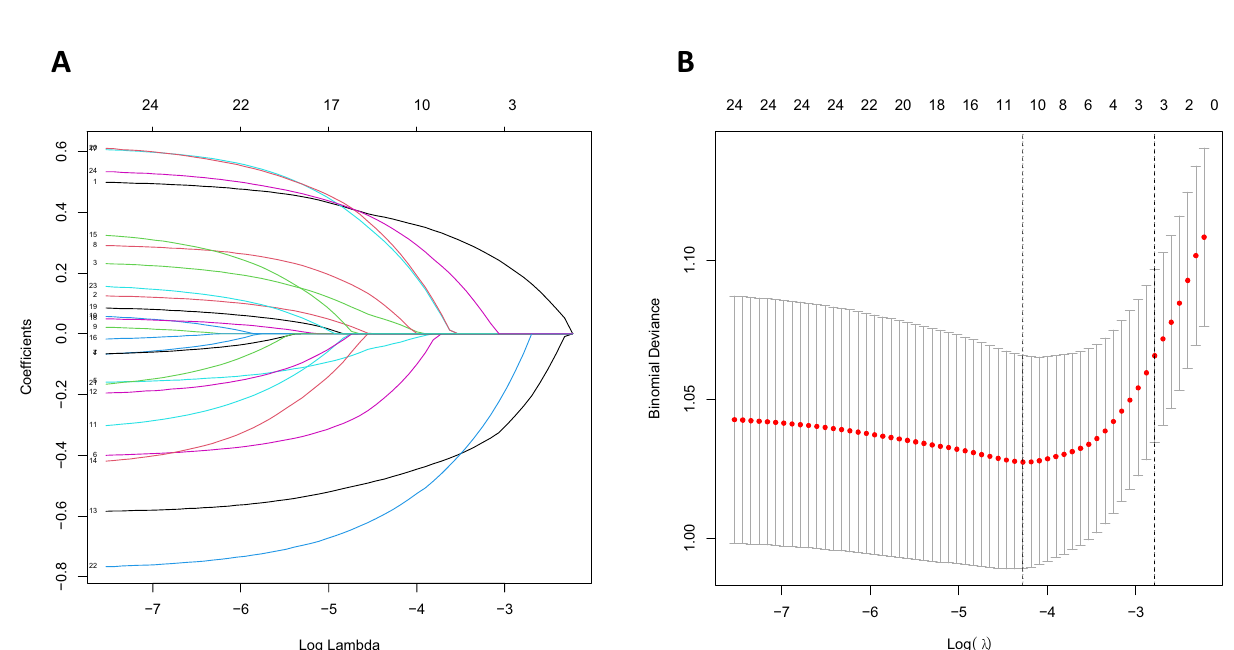
Figure 1. Selection of demographic and clinical characteristics of trichomonas vaginitis using the LASSO logistic regression model. LASSO, least absolute shrinkage and selection operator; SE standard